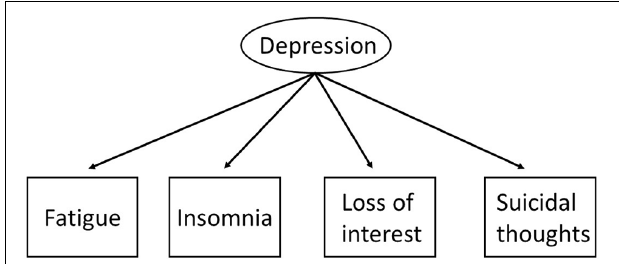
FIGURE 1 | An illustration of Depressionusing, a Latent Variable model.